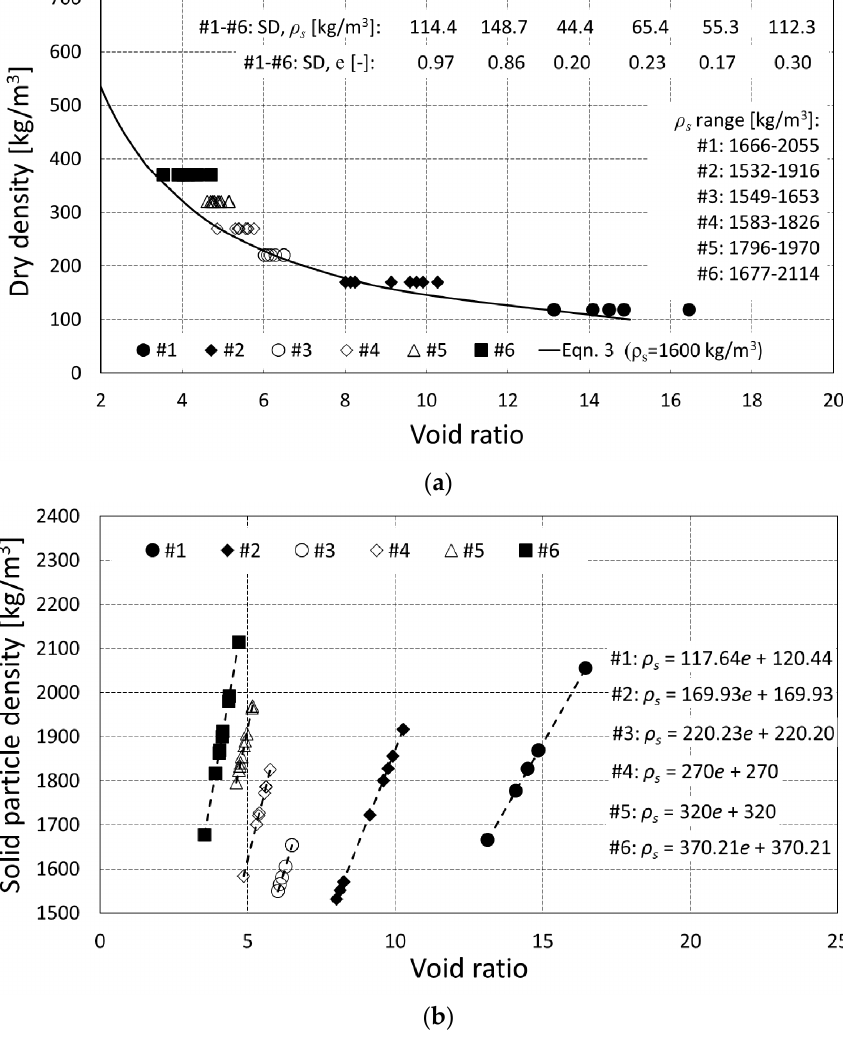
Figure 3. ( a ) Hyperbolic ρ d vs. e relationship under constant solid particle densities. ( b ) Linear ρ s vs. e relationship under constant dry densities.